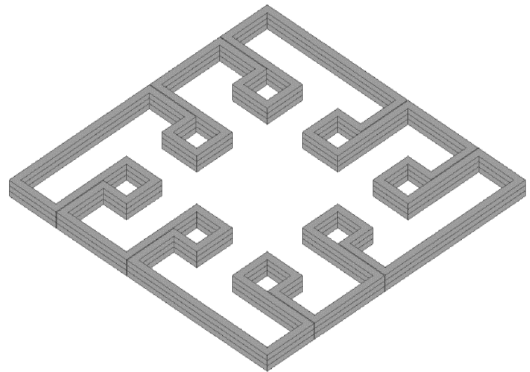
Figure 4. Input model of test printing bioink printability assessment. Table 1. Results of test printing with 4% collagen-based collagen with and without dECM granules. Collagen Collagen + dECM X ± S (CI, 95%, n = 24) After After After Printing After Printing Incubation Incubation 1.516 ± 0.482 Niches, mm 2 (1.249 ÷ 1.783) Lines,